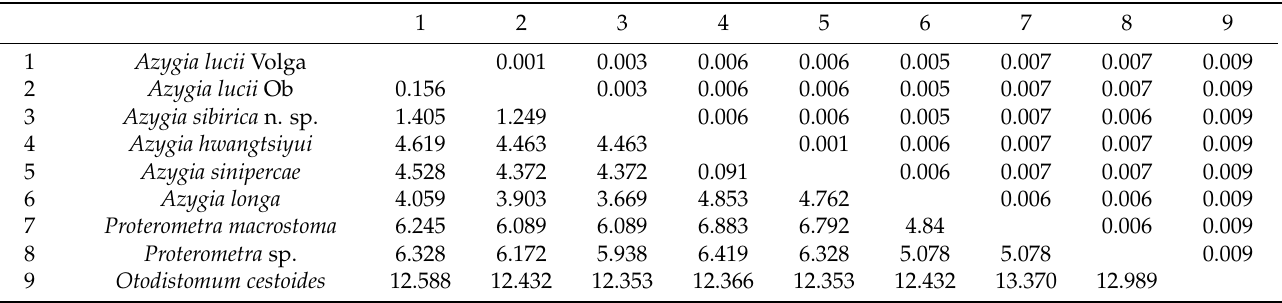
Table 3. Genetic p-distances estimated for eight species of the family Azygiidae based on the 28S gene sequences. Lower diagonal—genetic distances, in %; upper diagonal—standard